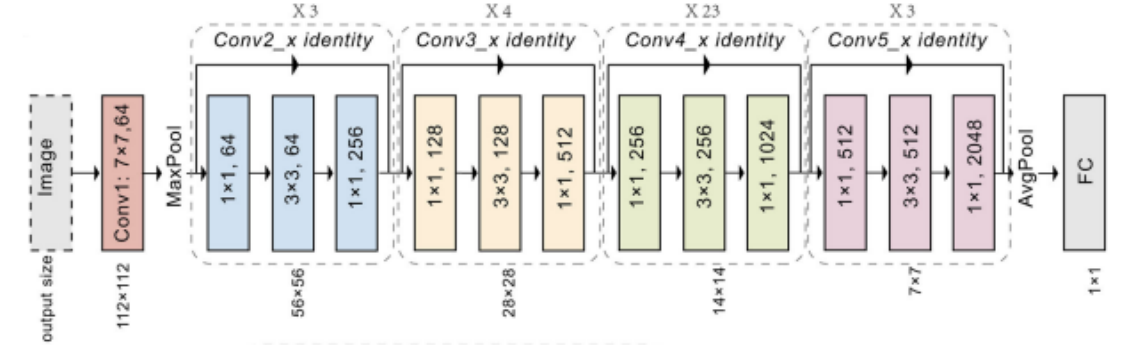
Figure 2. ResNet-101 framework.